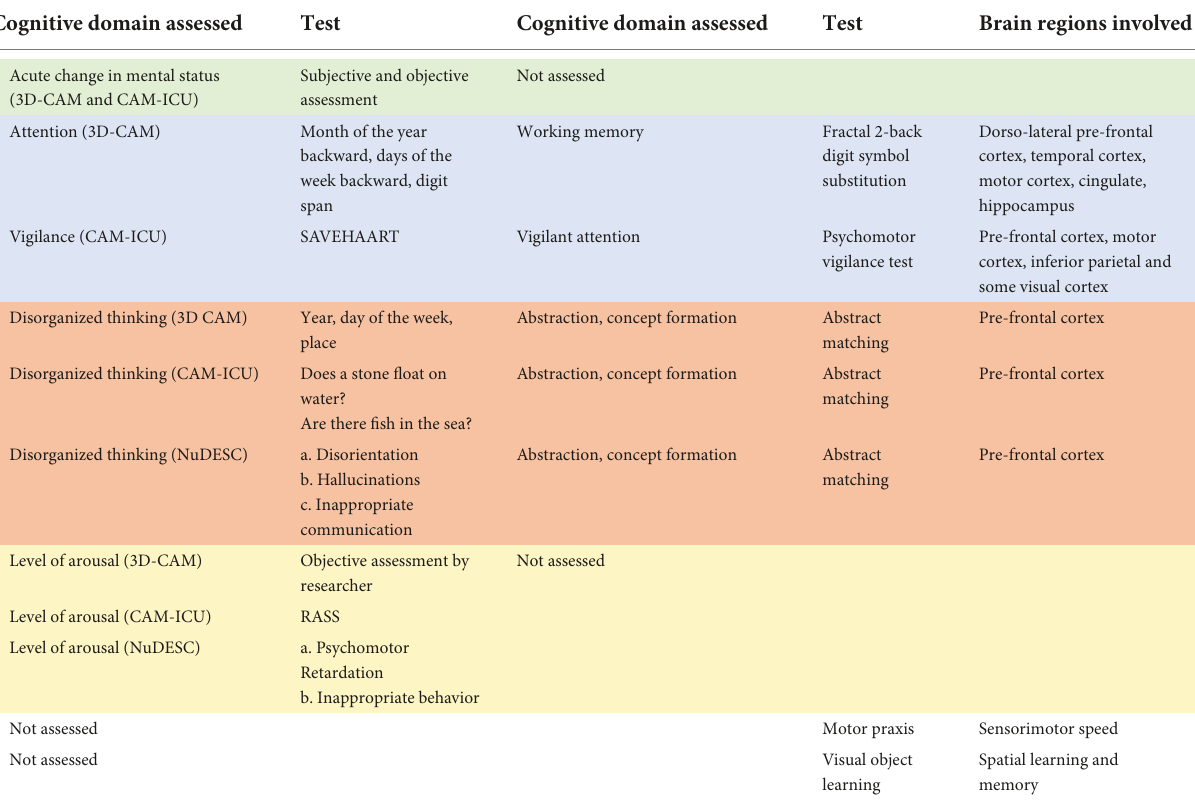
TABLE 1 The various postoperative delirium tests used in our study, divided into the individual cognitive domains, compared to those used in Basner and Mashour’s